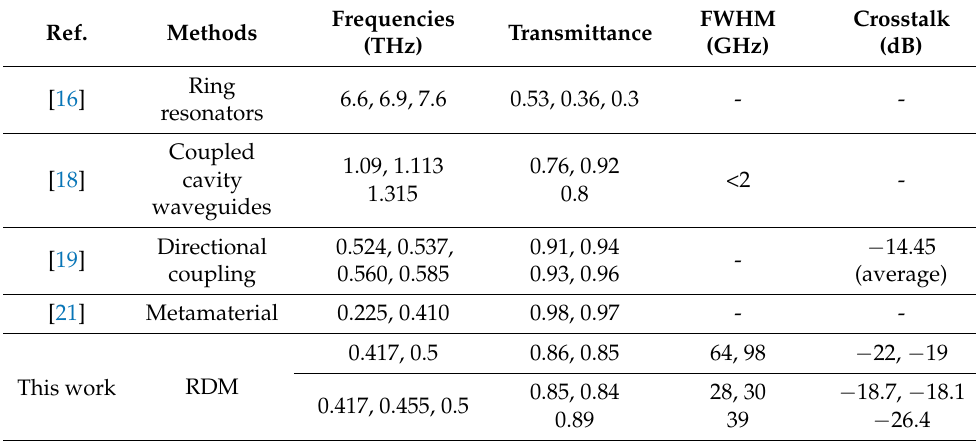
Table 1. Comparison of relevant parameters of this work with some others.